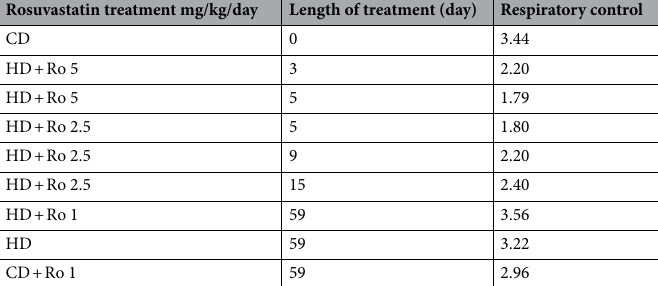
Table 5. Oxygen consumption by liver mitochondria in hypercholesterolemic mice treated with rosuvastatin 1.0, 2.5 or 5 mg/kg/day, after 60 Days of Treatment. CD control diet, HD hypercholesterolemic diet, Ro